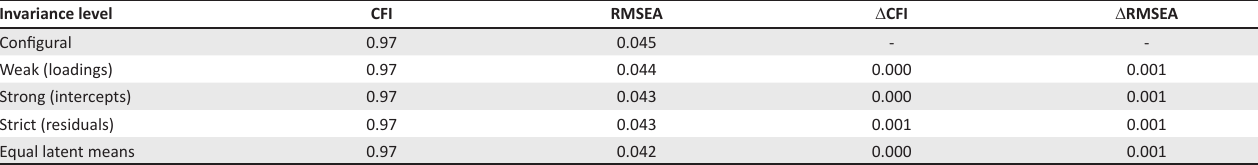
TABLE 2: Fit measures and changes in fit measures. Invariance